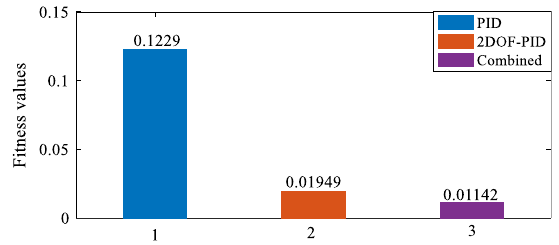
Fig. 13 Fitness values of the responses with various